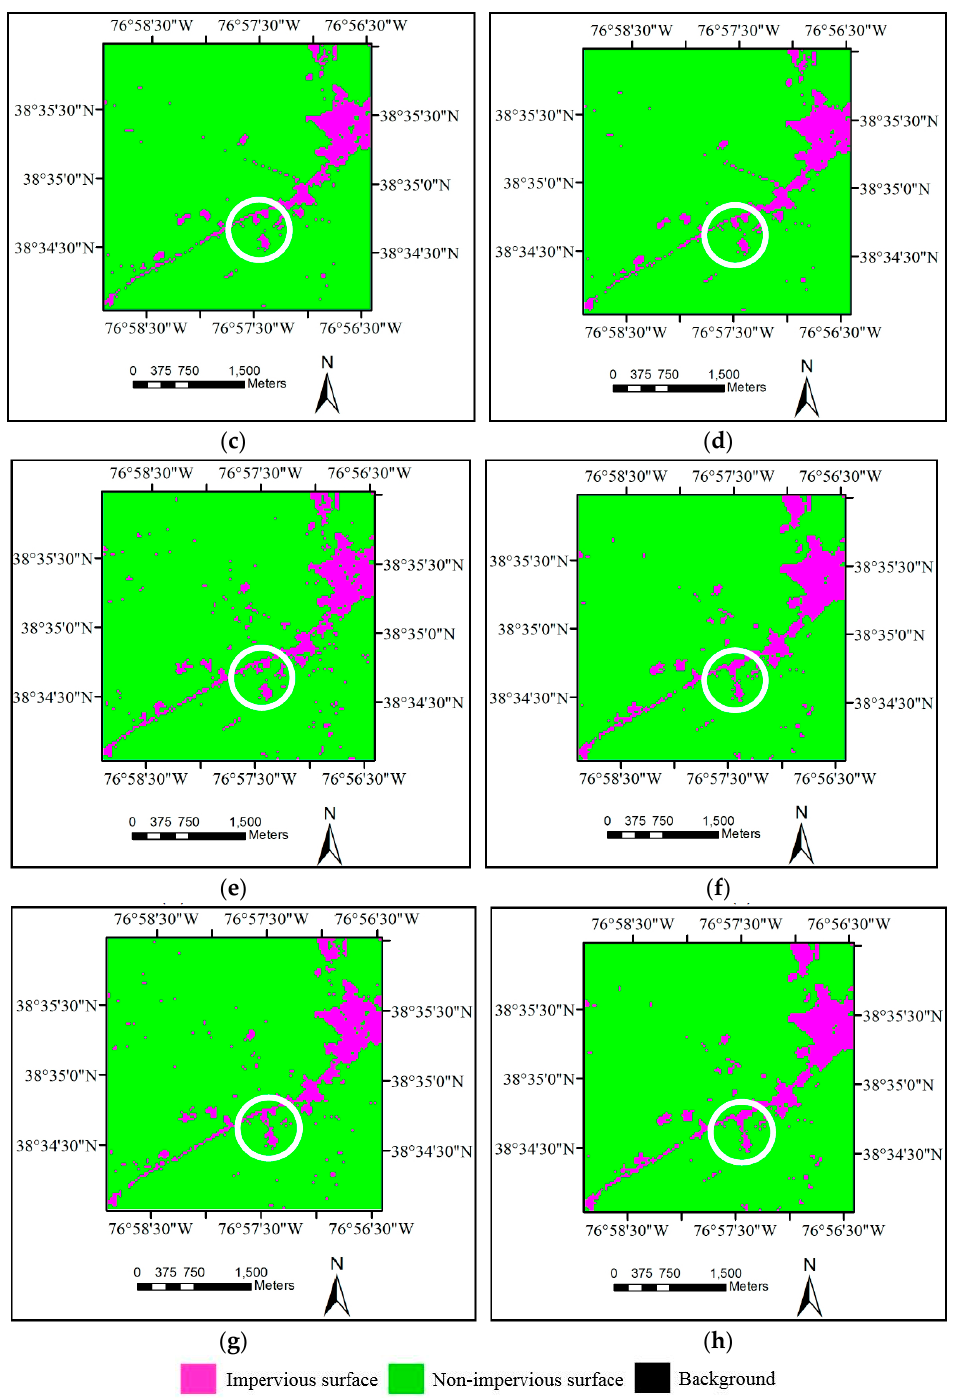
Figure 5. Hyperion dataset 1: ( a ) training data; and ( b ) test data. Estimation maps obtained by: ( c ) SVM applied to spectral data with RBF kernel (SPE-SVM); ( d ) SVM applied to spectral-spatial data with RBF kernel (SS-SVM); ( e ) RF applied to spectral data (SPE-RF); ( f ) RF applied to spectral-spatial data (SS-RF); ( g ) spectral feature sparse representation (SPE-SR); and ( h ) spectral-spatial feature sparse representation (SS-SR).